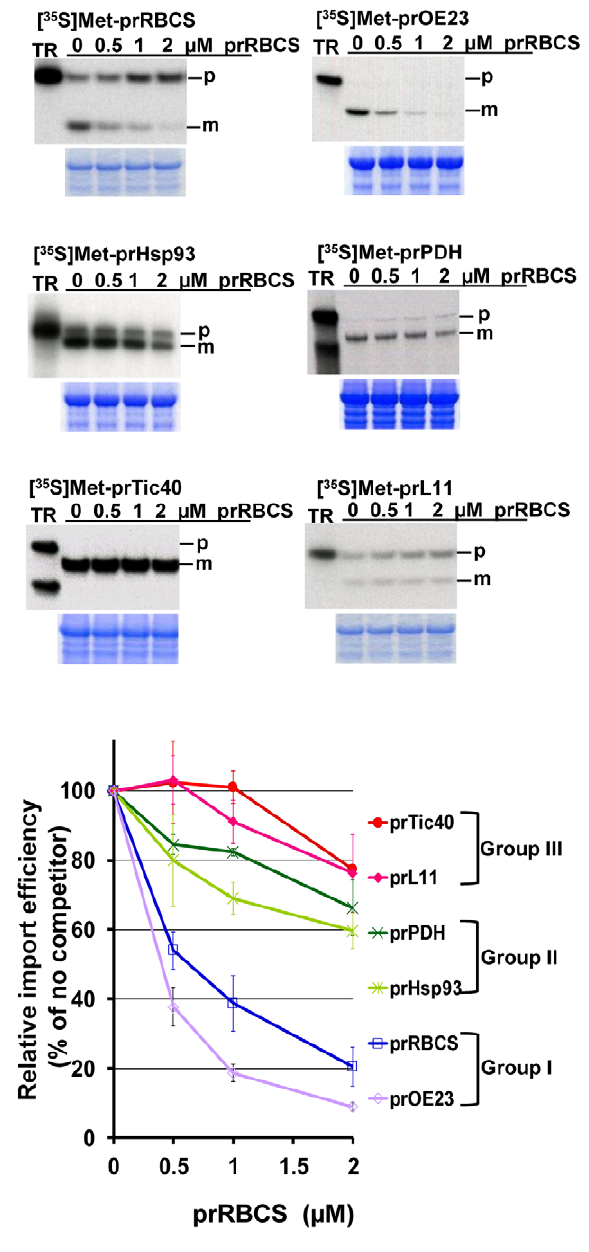
Figure 3. Import competition of a group I precursor with representative precursors of the three groups. Various [ 35 S]Met- labeled precursors were imported with 0 to 2 m M recombinant prRBCS, as labeled on top of the gel, into chloroplasts isolated from 8-d-old pea seedlings for 15 min. Intact chloroplasts were re-isolated and analyzed by SDS-PAGE, stained with Coomassie Blue, and dried for autoradiog- raphy. An equal amount of protein was loaded in each lane of the same gel. The region around the endogenous RBCL is shown below the autoradiograph to confirm that loading was equal in each lane. Imported mature protein was quantified using a phosphorimager and normalized to the amount of endogenous RBCL obtained by scanning the Coomassie Blue–stained gels. The line graph shows quantifications of relative import efficiencies, with the amount of mature protein imported in the absence of recombinant prRBCS set as 100%. Precursor groups are labeled on the right. Data shown are means 6 SD, n =3. m, mature form; p, precursor form; TR, in vitro–translated precursor proteins before import.